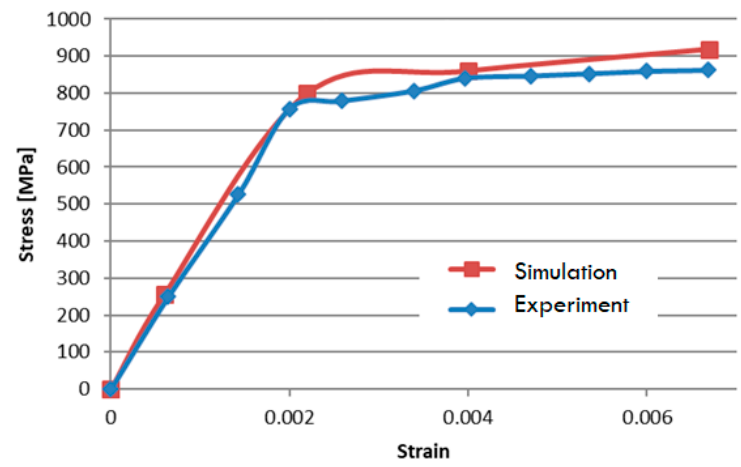
Figure 2. Calibration of coefficients by comparison of experimental data and simulation.